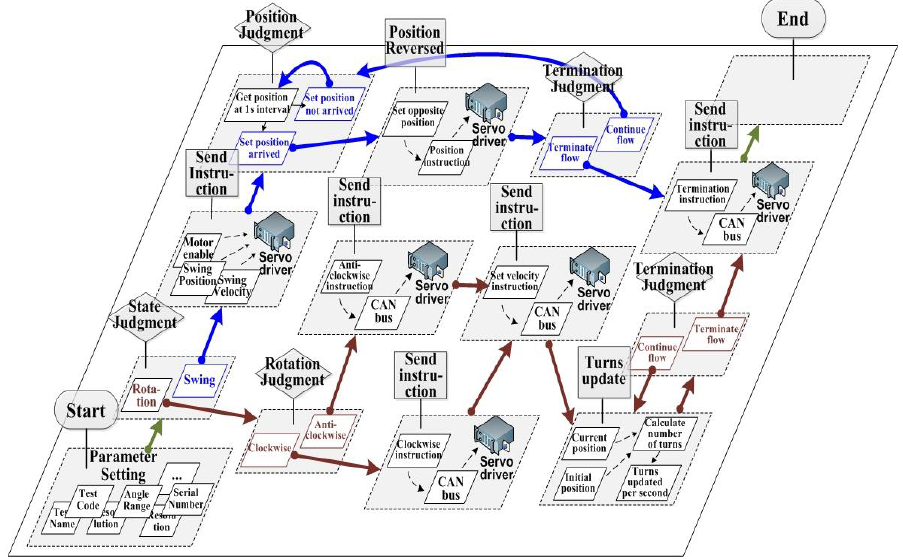
Figure 4. Software control process architecture of the swing life